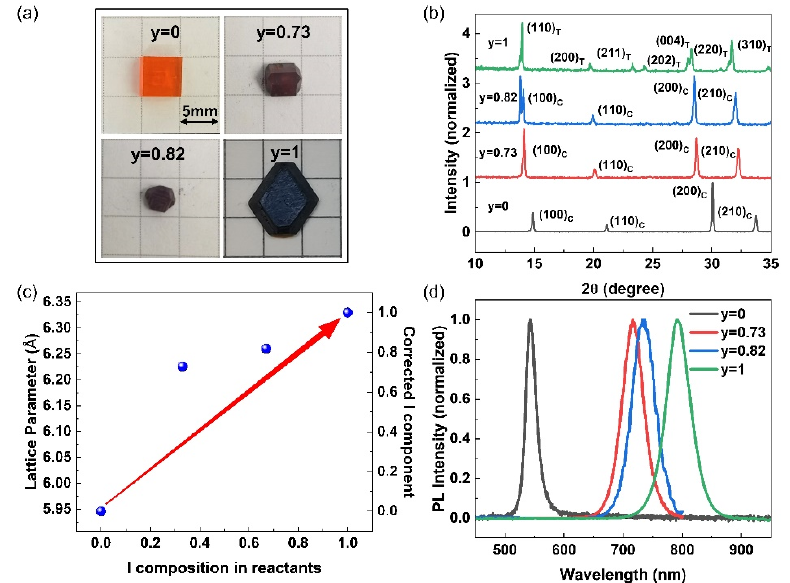
Figure 1. ( a ) Photos of MAPb(Br 1 − y I y ) 3 SCs with varied I compositions grown by ITC method. ( b ) XRD of MAPb(Br 1 − y I y ) 3 SCs in the range of 10° < 2 θ < 35°. ( c ) The correlation between lattice parameter and I compositions in reactants for MAPb(Br 1 − y I y ) 3 SCs. The corrected I composition was determined by lattice parameter and the tetragonal lattice was treated as pseudo-cubic. ( d ) PL emission spectra of MAPb(Br 1 − y I y ) 3 SCs with indicated I compositions at room temperature.